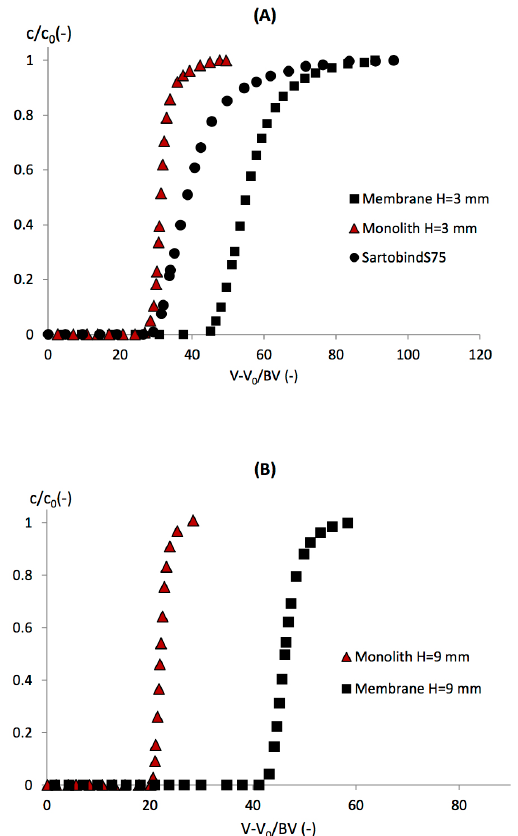
Figure 4. Simulated and experimental LF binding breakthrough curves for ( A ) the membrane, the monolith with H = 3 mm in the CIM housing and the Sartobind S75 device, and ( B ) the membrane and the monolith with H = 9 mm. The experimental data were obtained using 100 mM phosphate buffer pH 6.0 at a BSA/LF initial concentrations of 2/1 and a flow rate of 12.0 BV · min − 1 , except for the monolith with H = 9 mm, for which the flow rate was 0.40 BV · min − 1 .